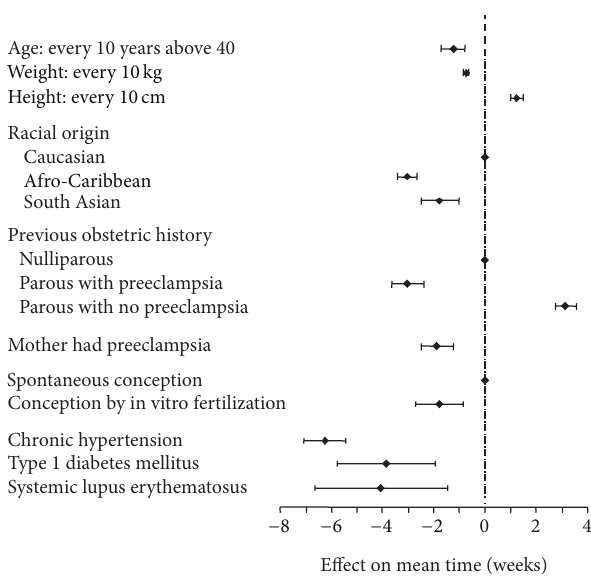
Figure 2: Effects of maternal characteristics (with 95% confidence intervals) on the gestational age at delivery for preeclampsia. This effect is expressed as gestational weeks by which the expected gestational age at delivery for preeclampsia is